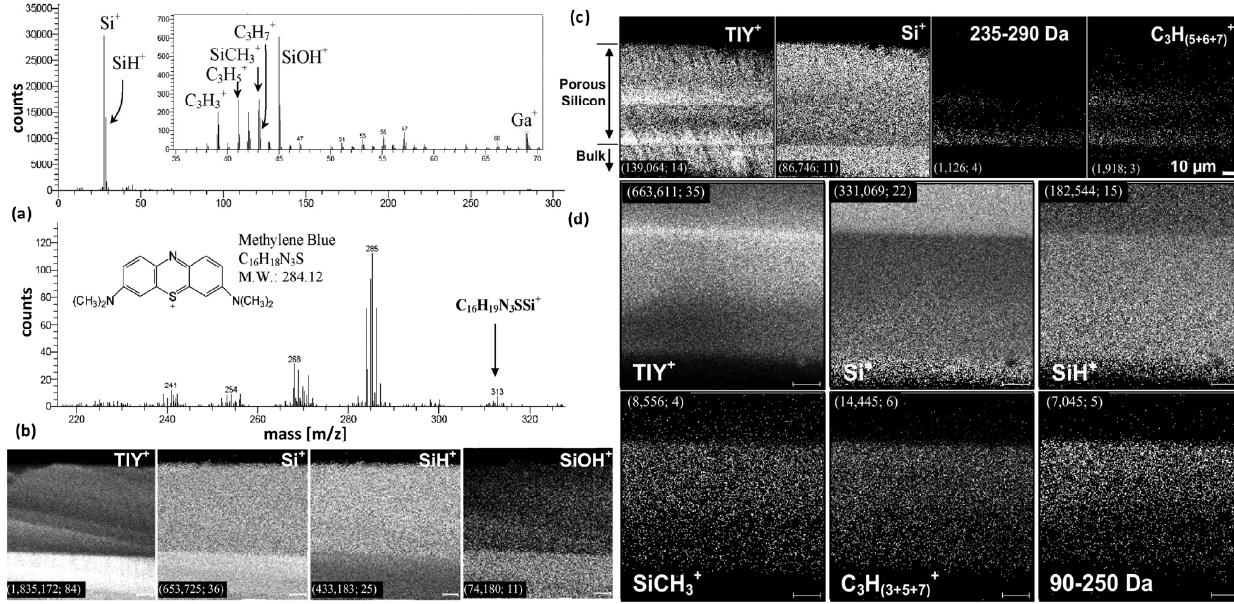
Figure 17. ( a ) and ( b ) Positive TOF-SIMS images of the porous region of a “blank” porous silicon, ( a ) and ( c ) methylene blue, and ( d ) papain loaded wafer. Adapted with permission from [245], Copyright 2009